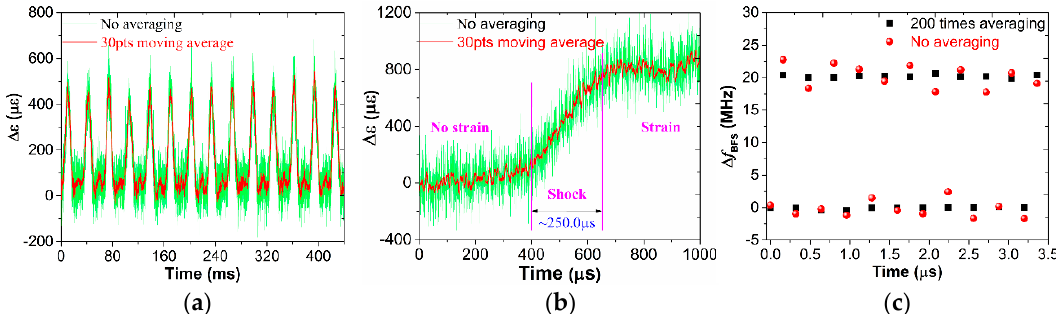
Figure 16. The dynamic measurement [1] for ( a ) a periodic mechanical vibration, ( b ) a mechanical shock, and ( c ) a switch event.